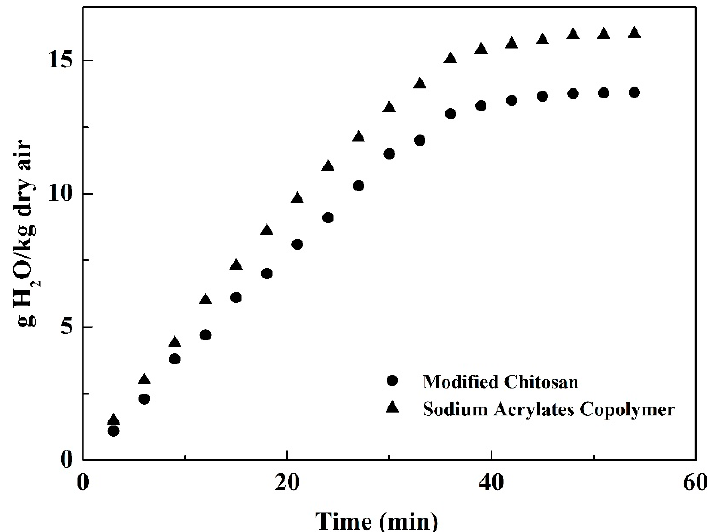
Figure 8. Change of spatial humidity with time for different emulsifiers.